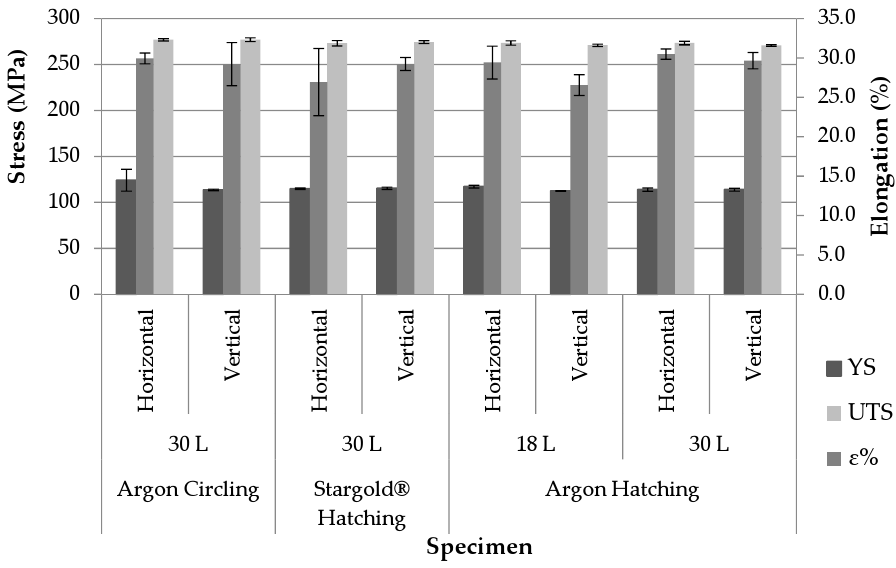
Figure 17. Thermocouple temperatures of layers in parts manufactured to test mechanical properties with Argon Q1 + 18 L/min + hatching condition.